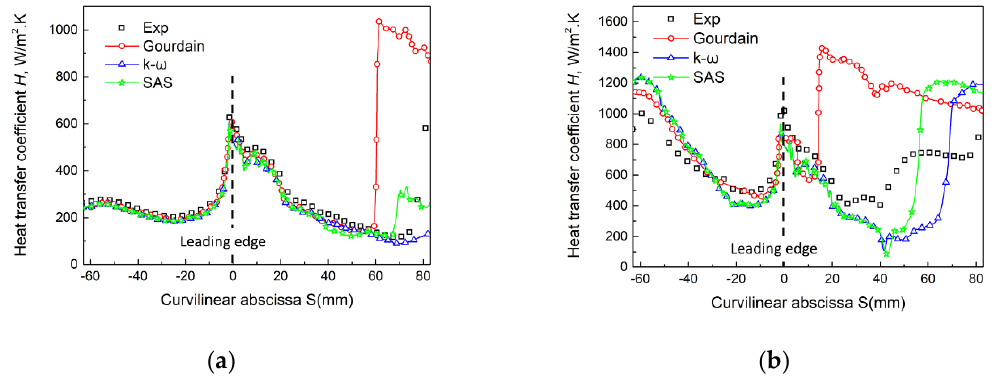
Figure 6. Vane surface heat transfer coefficient H : ( a ) MUR129; ( b ) MUR241.